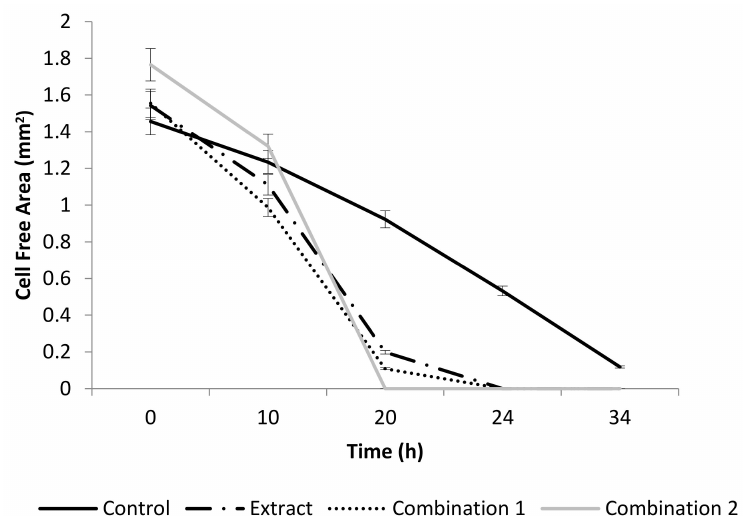
Figure 1. The effect of A. strigosa extract and compounds on wound healing in vitro. The rate of gap closure in cultured human dermal fibroblasts (scratch assay: in vitro model of wound healing) at 0, 10, 20, 24, 34 h after wound generation. Control was untreated fibroblasts. Crude extract was added at a concentration of 50 µ g/mL. The combination 1 of tested compounds included: quercetin 3- O - rutinoside at a concentration of 50 µ g/mL, ellagic acid at a concentration of 10 µ g/mL and kaempferol 3- O - β -rhamnopyranosyl(1 → 6)- β -glucopyranoside at a concentration of 10 µ g/mL. Combination 2 of the tested compounds included: kaempferol at a concentration of 10 µ g/mL and ellagic acid at a concentration of 1 µ g/mL. Data from three independent experiments are shown (mean ±